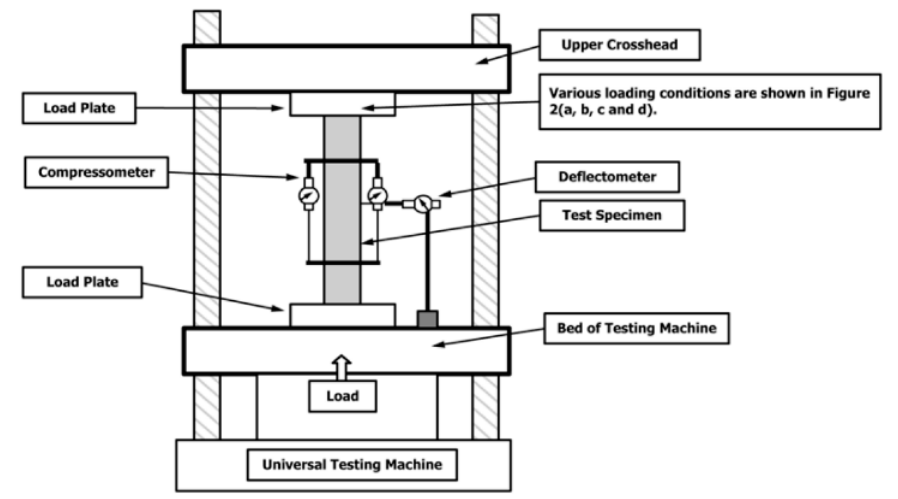
Figure 6. Schematic diagram of test setup.